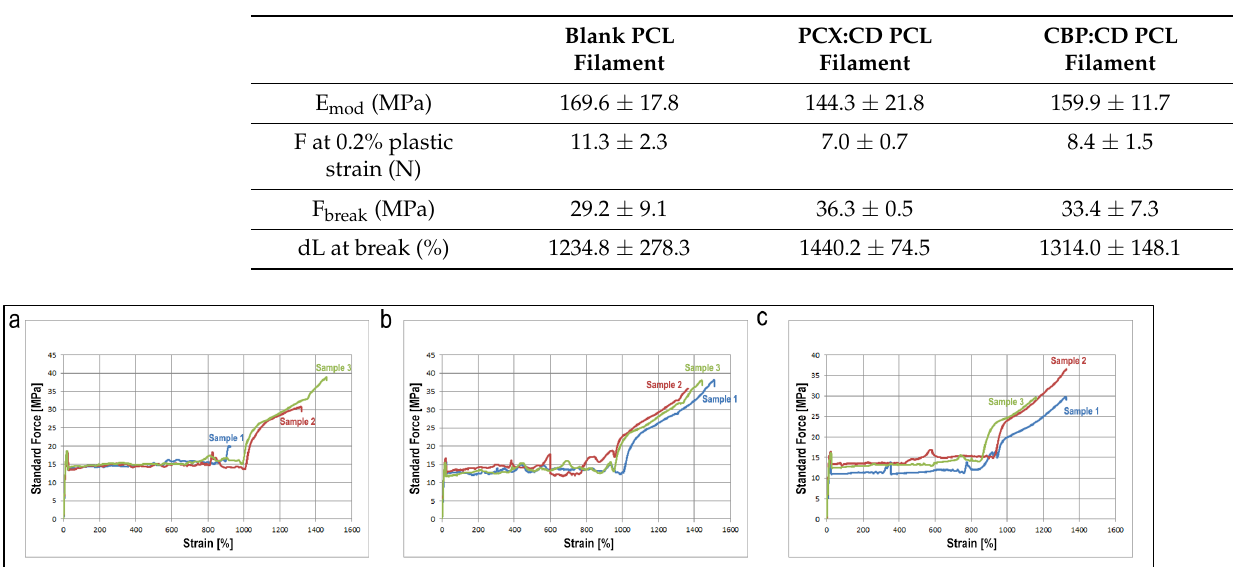
Table 2. Mechanical properties data of blank and drug-loaded filaments ( n = 3).